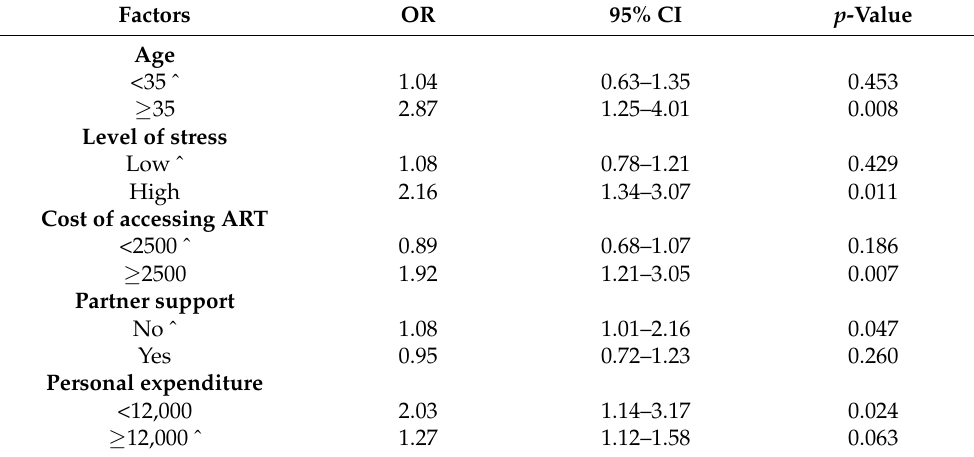
Table 3. Multivariate analysis of factors associated with failing to achieve pregnancy through ART.